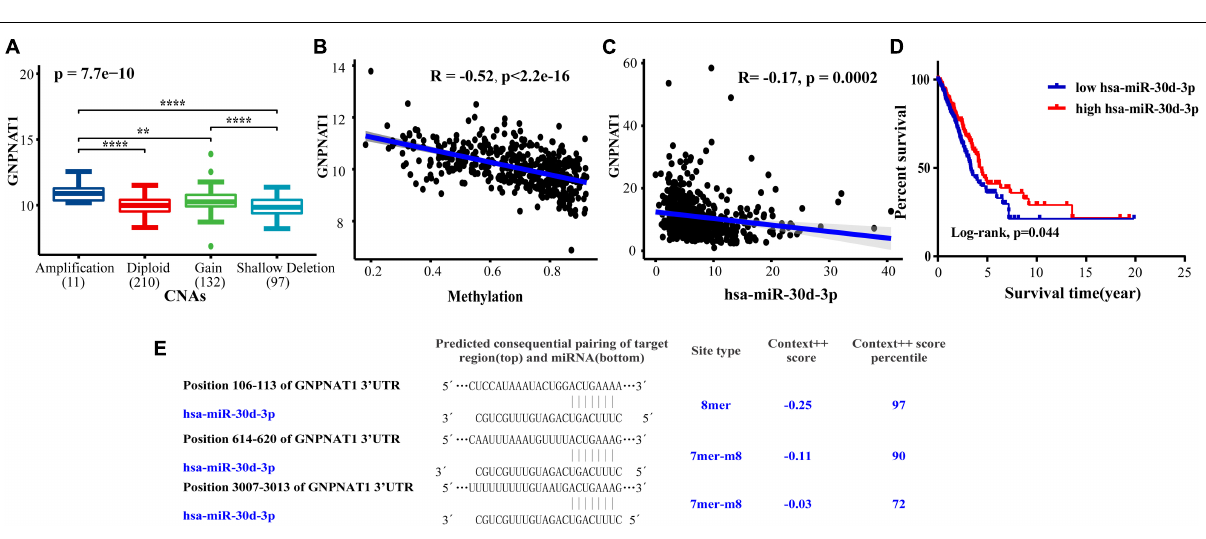
metabolism that links glucose, lipid, and protein